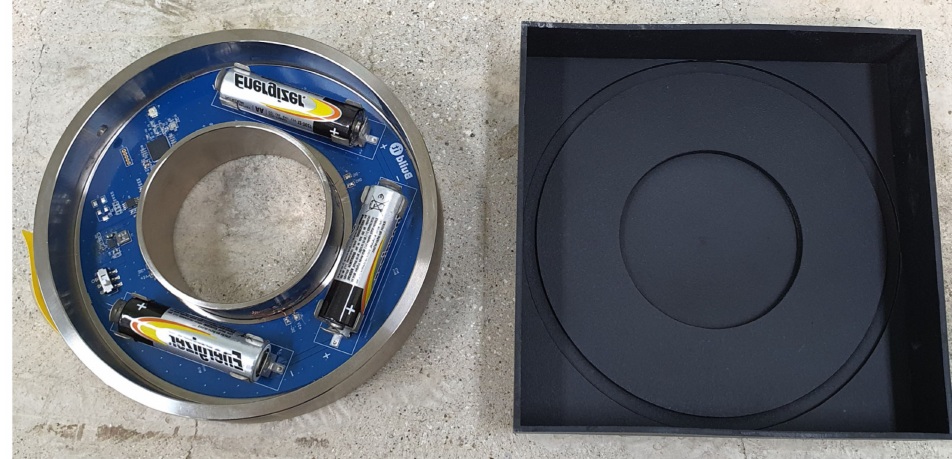
Figure 12. Wireless Bluetooth load-cell prototype and rubber casing.